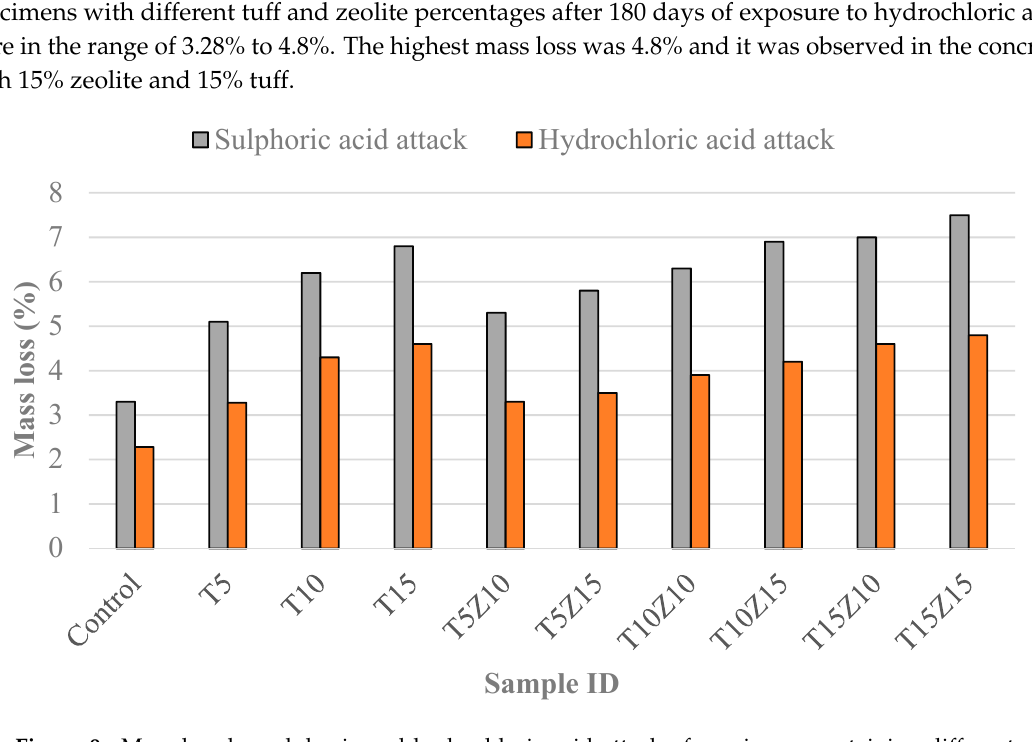
Table 4. Compressive strength after 236 days immersion in acid.